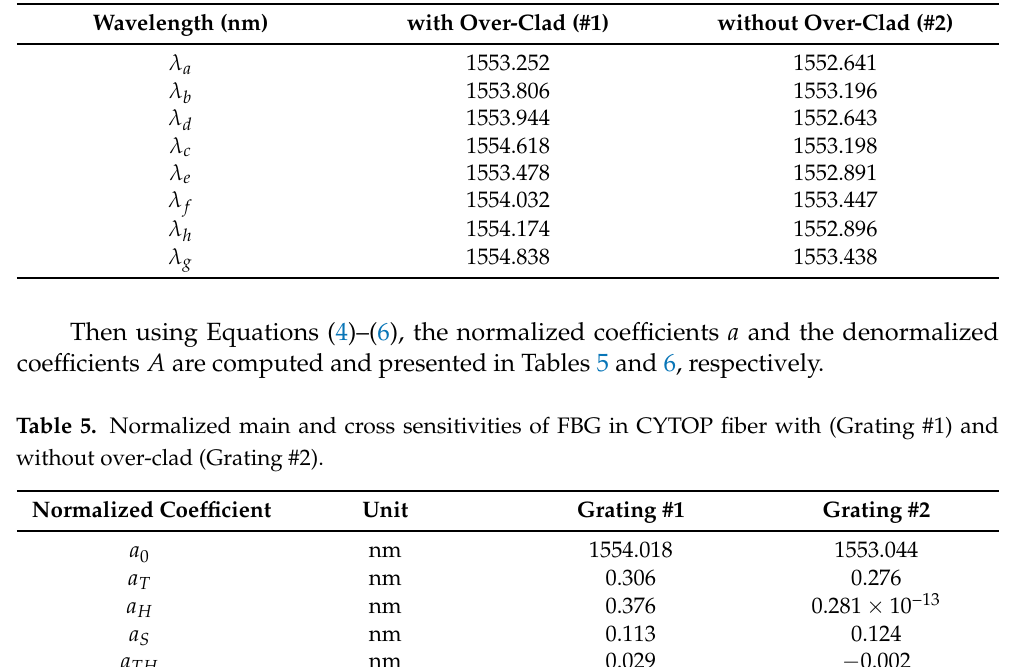
Table 4. Experimental results for the Bragg wavelengths at the eight corner points of Figure 1.